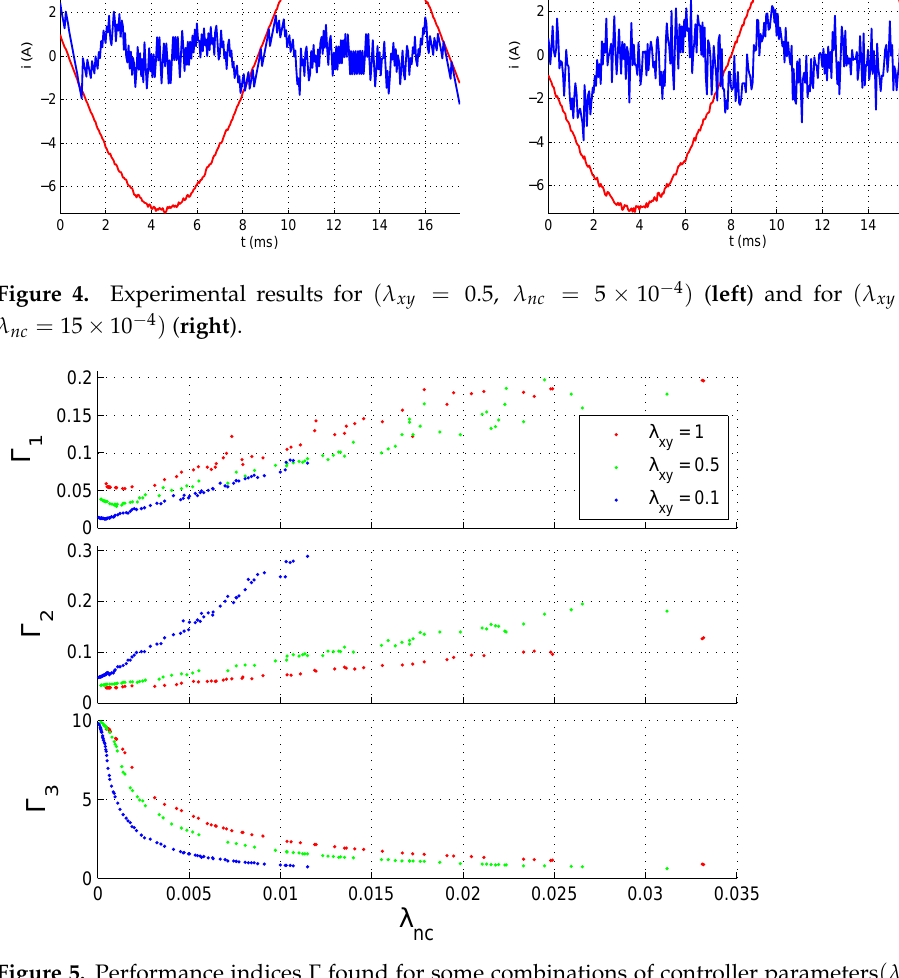
Figure 5. Performance indices Γ found for some combinations of controller parameters ( λ xy , λ nc ) . The legend and horizontal rule apply to all